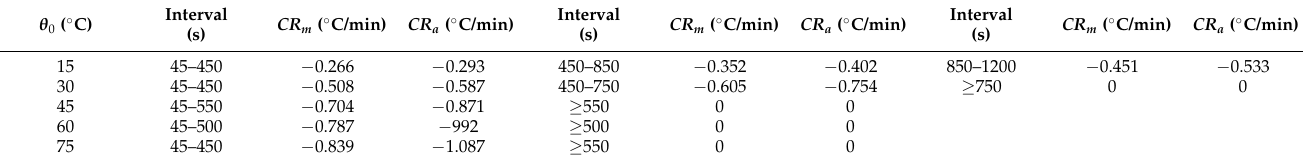
Table 3. Cooling rates of the temperatures T m and T a during time intervals of the cycles for each inclination angle examined.